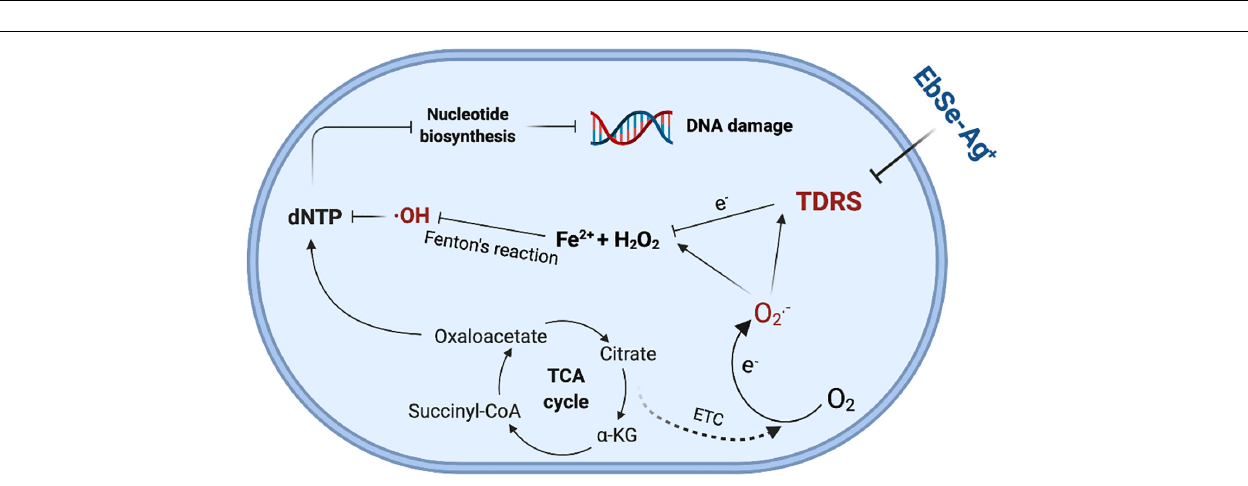
FIGURE 12 | The illustration of bactericidal effect of EbSe-Ag +